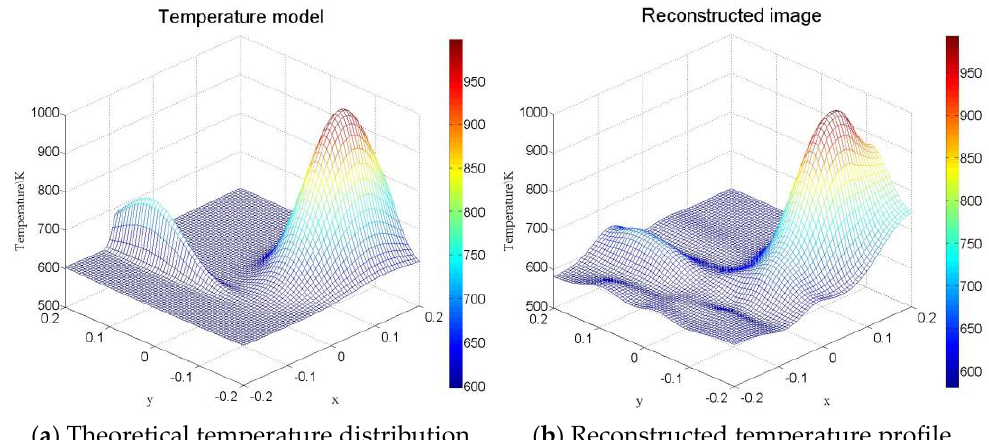
Figure 7 . Multipeak temperature distribution (Model III).